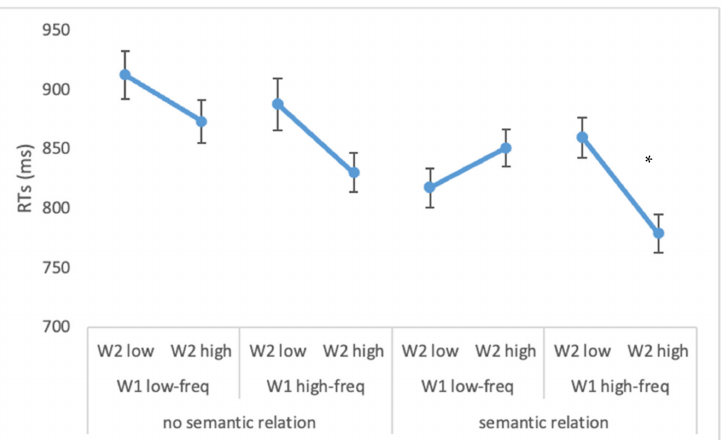
Figure 2. Experiment 1. Mean vocal reaction times (ms) for the semantic related and unrelated conditions as a function of W1 and W2 frequencies. The figure represents the interaction between W1 frequency × W2 frequency × semantic relation. Bars represent standard errors. The asterisk (*) indicates statistically significant